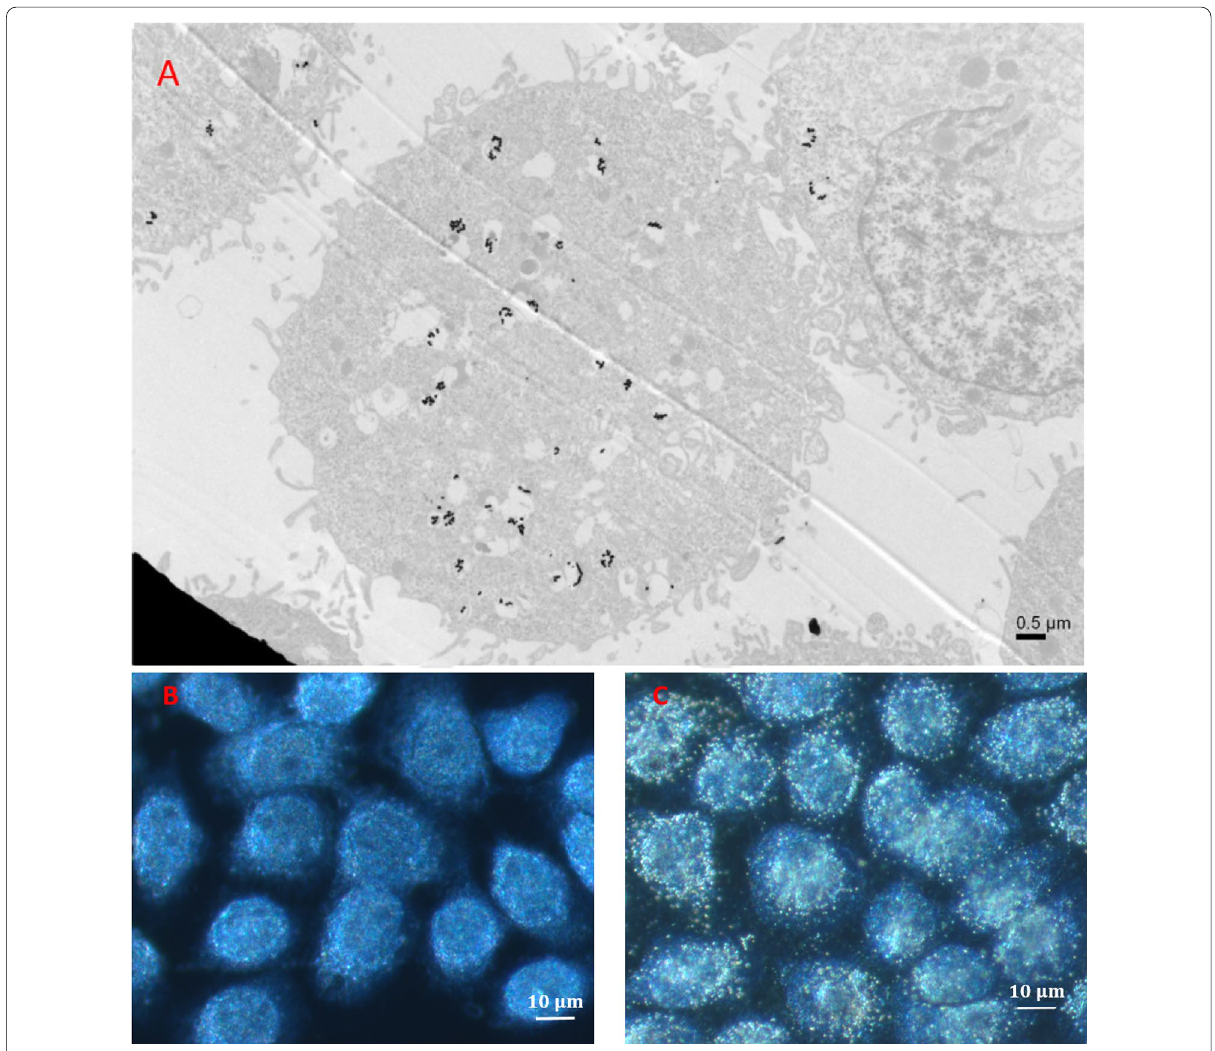
Fig. 1 A TEM image of GNPs‑uptake cells. Black dots in the image are GNPs; certain number of GNPs are enclosed in vesicles through the endocytosis and fusion. B and C the dark‑field microscope images of the controls and GNPs‑uptake cells. Bright spots in C are the light scattering of these GNPs contained in vesicles. In contrast, there is no light scattering in